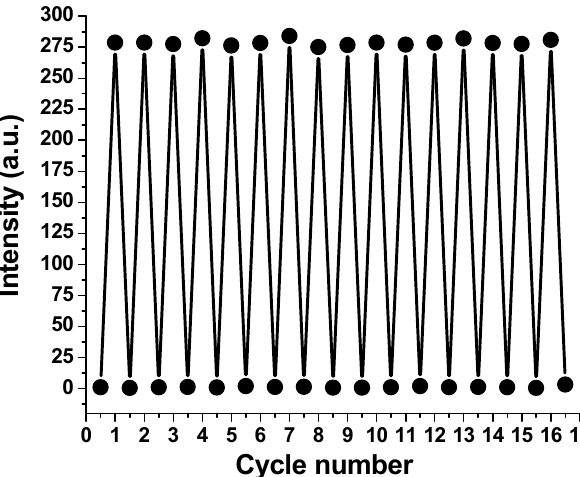
Figure 5. Emission intensity at 518 nm after UV-irradiation for 100 s, and after exposure to darkness for an hour; concentration of pigment is 8 wt%.